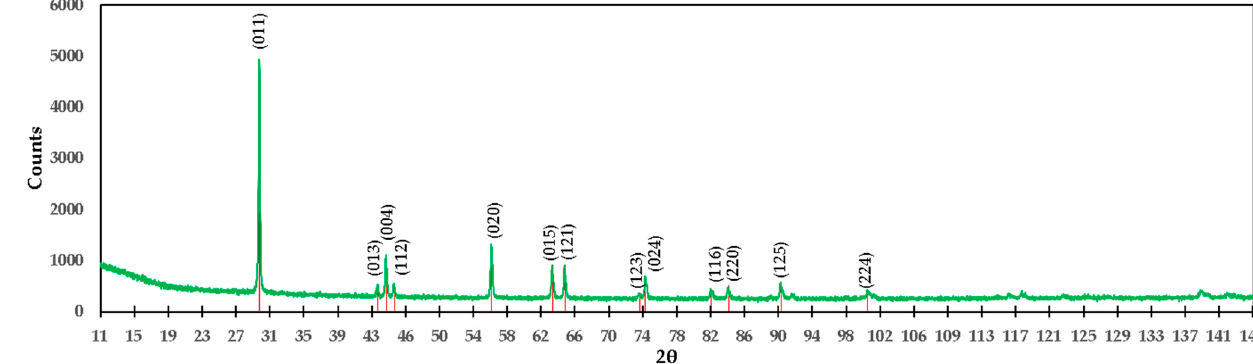
Figure 15. Diffractogram of the M3 formulation (high-purity titania), showing the identification of TiO 2 .